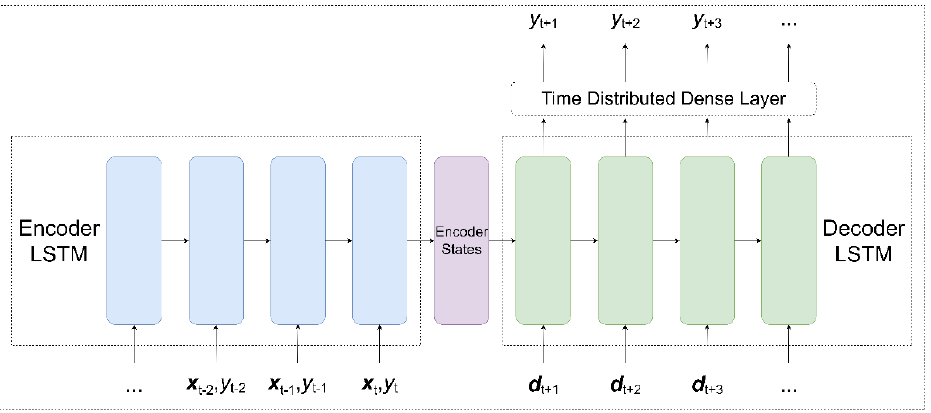
Figure 9. Our DNN architecture. The encoder LSTM takes in lagged observations of the water level 𝑦 and exogenous variables 𝒙 and encodes them into a hidden state 𝒉 and a cell state 𝒄 . These encoder states are then used as the initial states for the decoder LSTM, which accepts known future dates 𝒅 as input. The decoder outputs are then passed to a time distributed dense layer, which generates the forecasts.